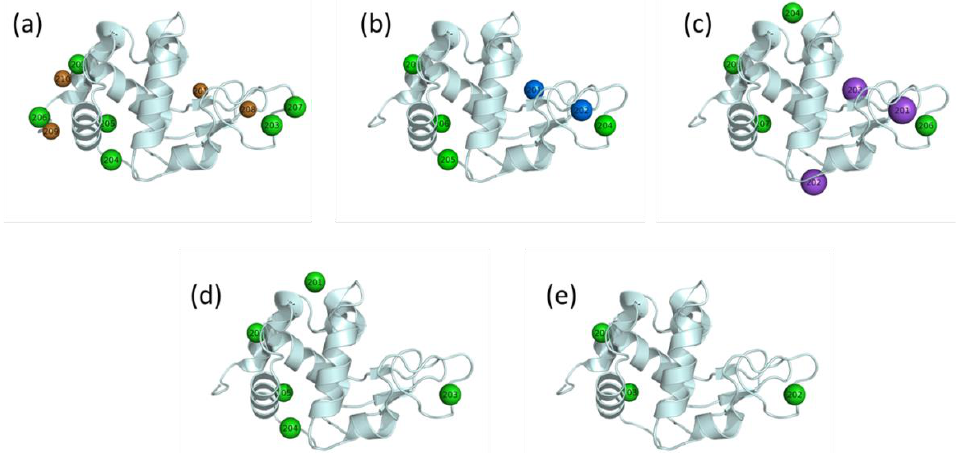
Figure 1. The location of metal (red sphere) and chloride (green sphere) ions associated with the lysozyme molecule in Cu- ( а ), Ni- ( b ), Na- ( c ), K- ( d ), and Li- crystals ( e